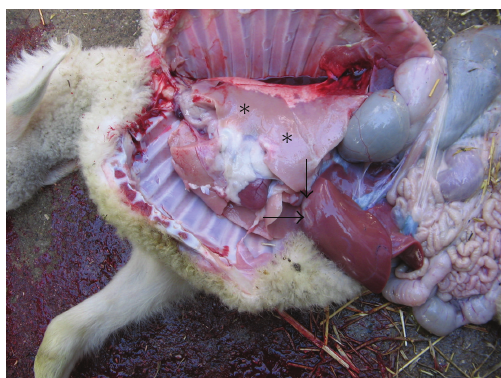
Figure 1: Necropsy revealed the presence of abscesses in the liver (arrows) and lungs of all five lambs necropsied. In the lamb shown here, extensive consolidation, mainly of the caudal portion of the lungs, was also observed (asterisks).